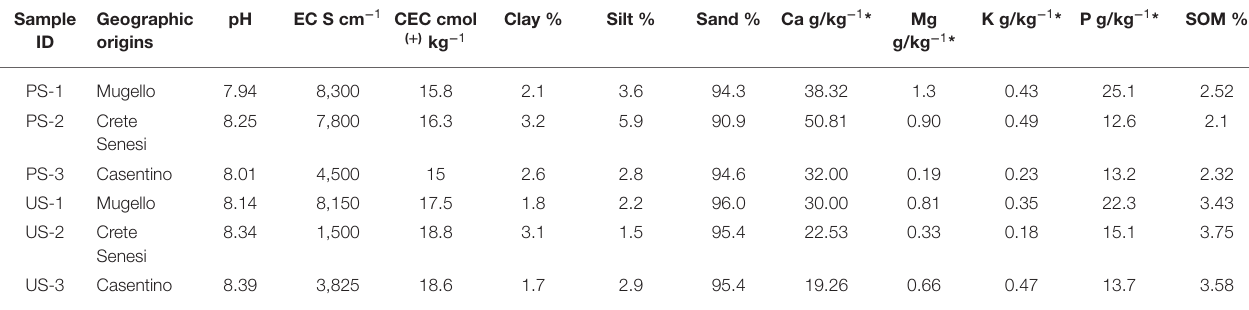
TABLE 4 | Results of chemical analyses of PS and US samples. Sample